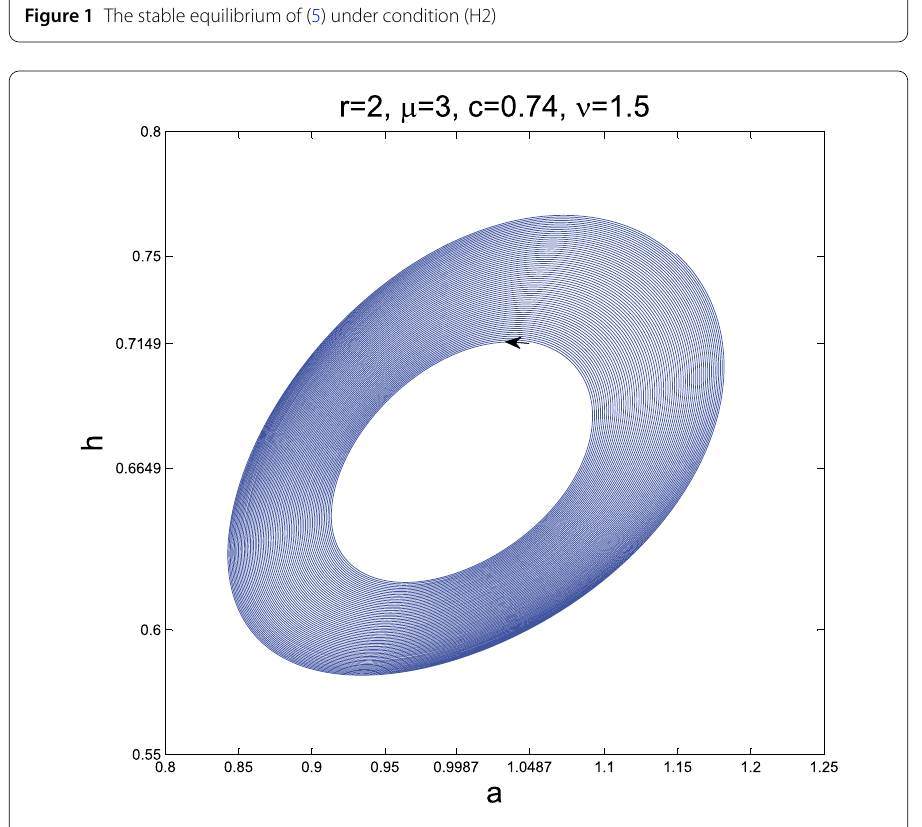
Figure 2 The unstable equilibrium of (5) under condition